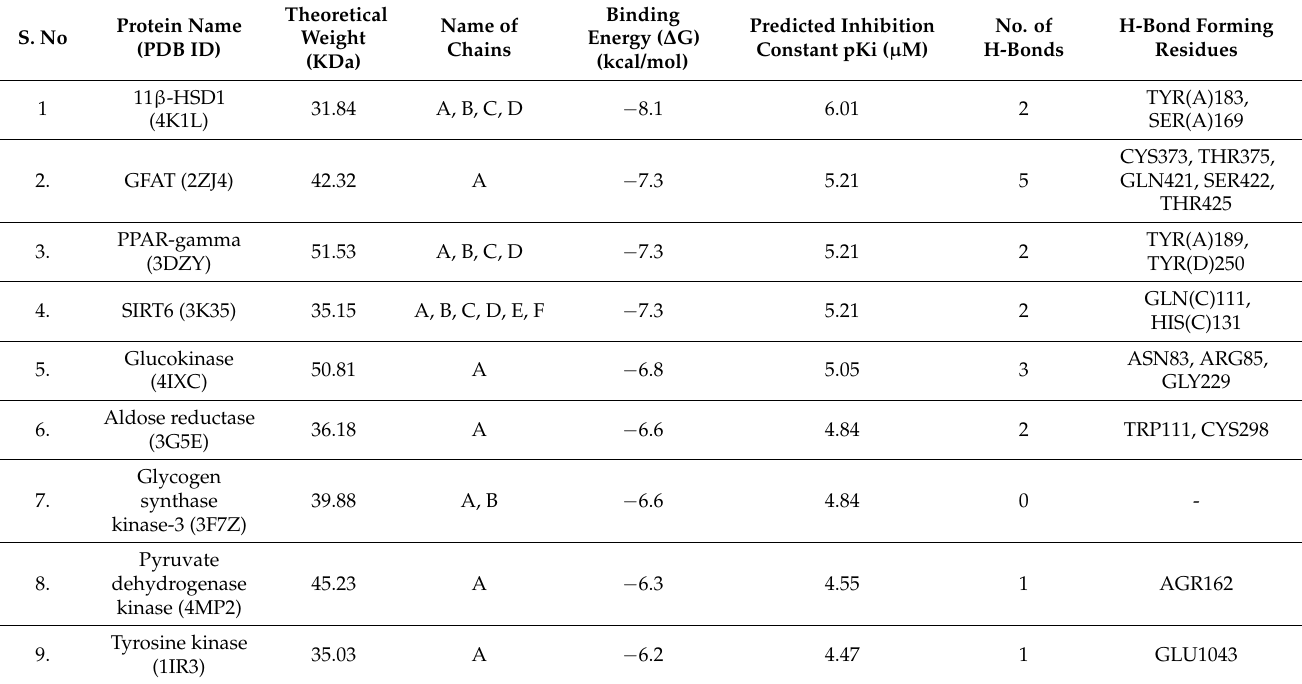
Table 1. AutoDock Vina results showing binding energies and inhibition constant of ABA with different proteins related to diabetes